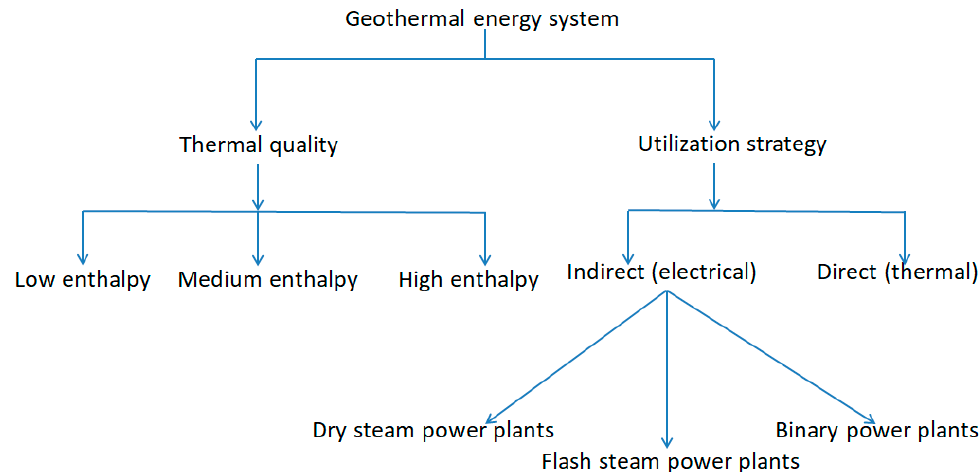
Figure 11. Classification of geothermal energy systems.